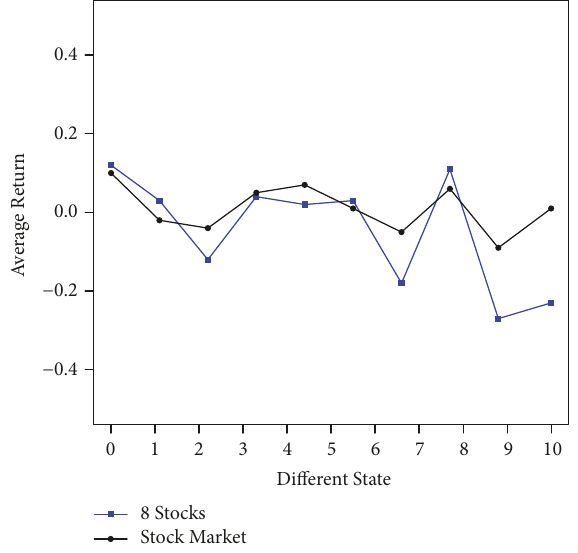
Figure 2: Average returns from the entire stock market and from the 8 selected stocks under different